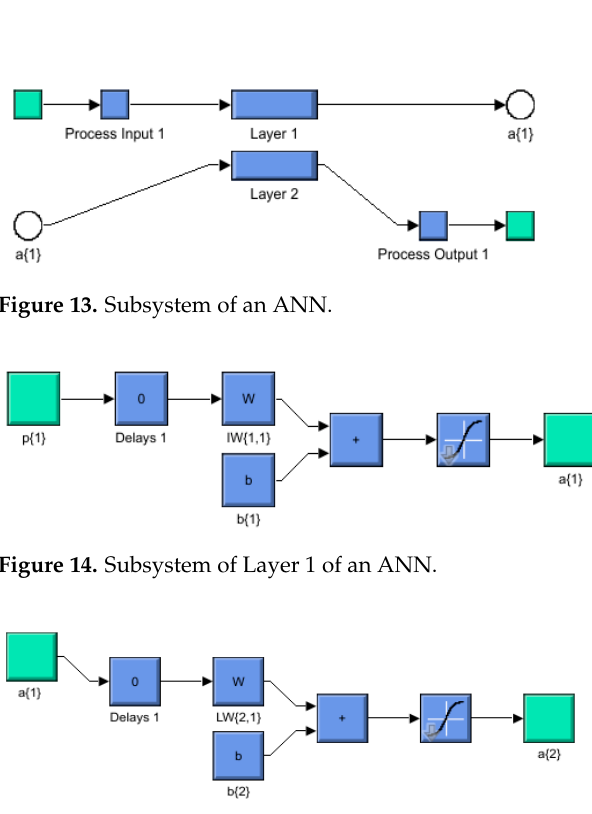
Figure 15. Subsystem of Layer 2 of an ANN.